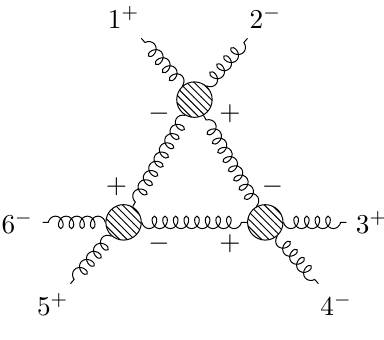
Figure 1 . Three-mass